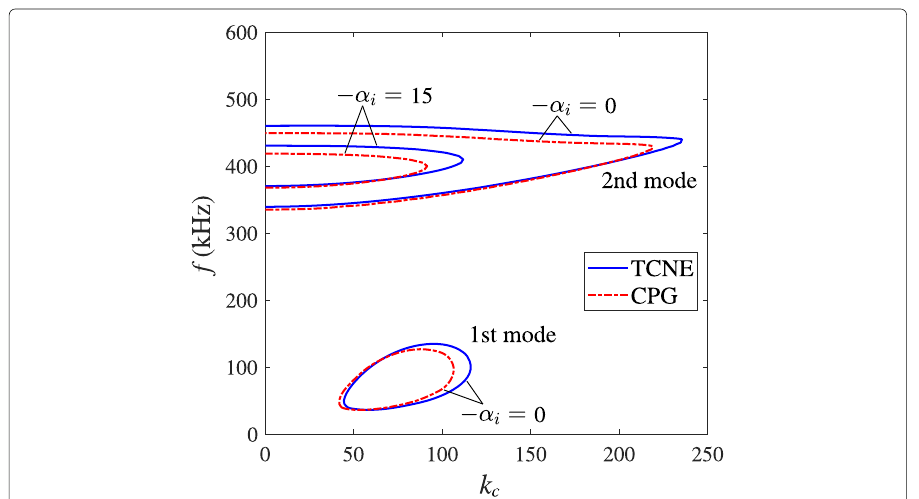
Fig. 12 Growth rate contours ( − α i , 1 / m ) with the azimuthal wavenumber for the TCNE and CPG cases at s = 1.6m